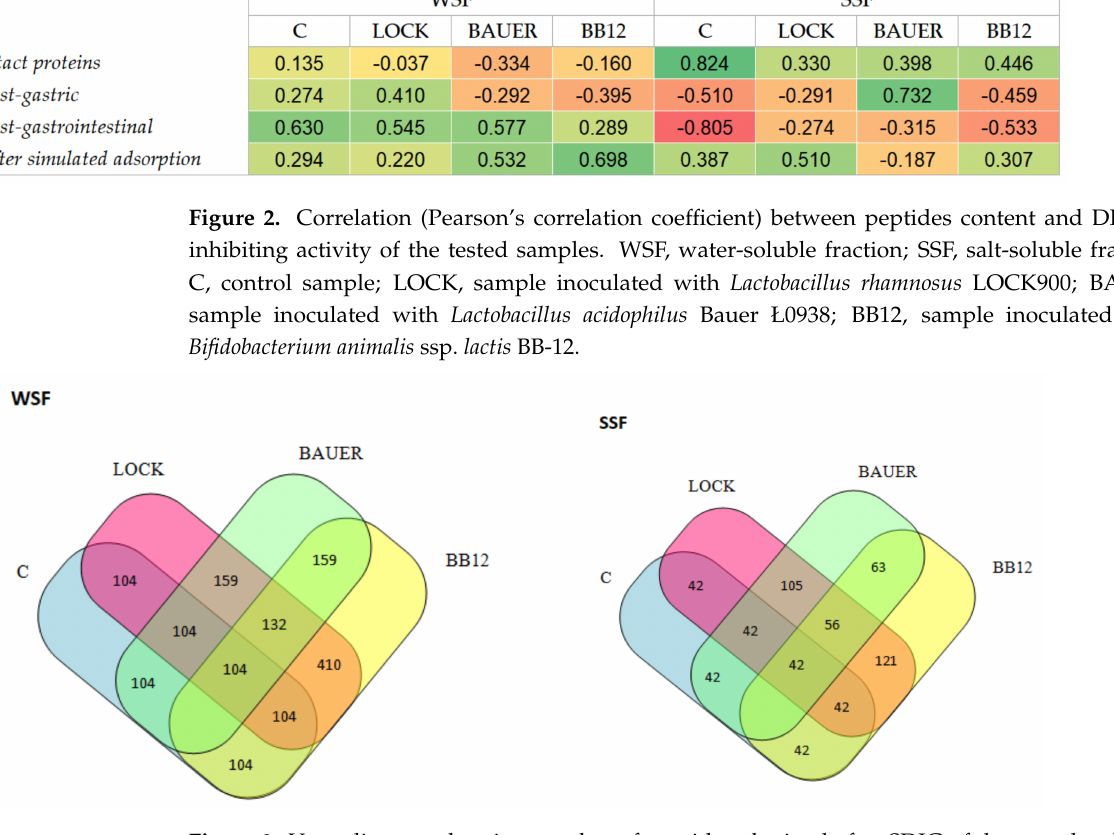
Figure 3. Venn diagram showing number of peptides obtained after SDIG of dry-curedpork loin after 180 days of ageing. WSF, water-soluble fraction; SSF, salt-soluble fraction; C, control sample; LOCK, sample inoculated with Lactobacillus rhamnosus LOCK900; BAUER, sample inoculated with Lactobacillus acidophilus Bauer Ł0938; BB12, sample inoculated with Bifidobacterium animalis ssp. lactis